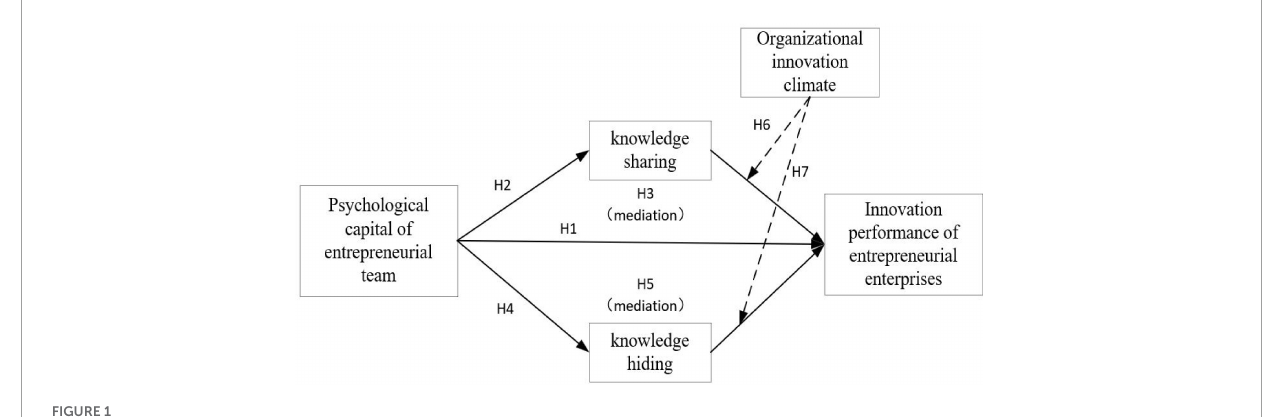
FIGURE1 Theoretical model and research